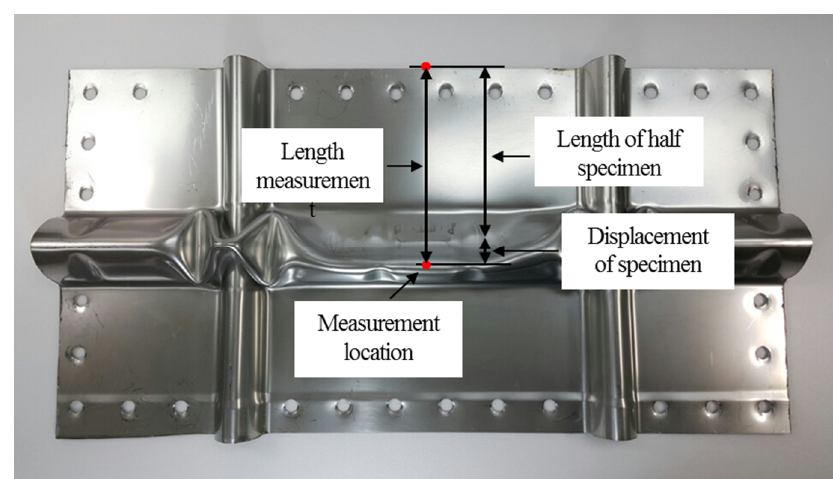
Figure 6. Displacement measurement method for primary barrier.